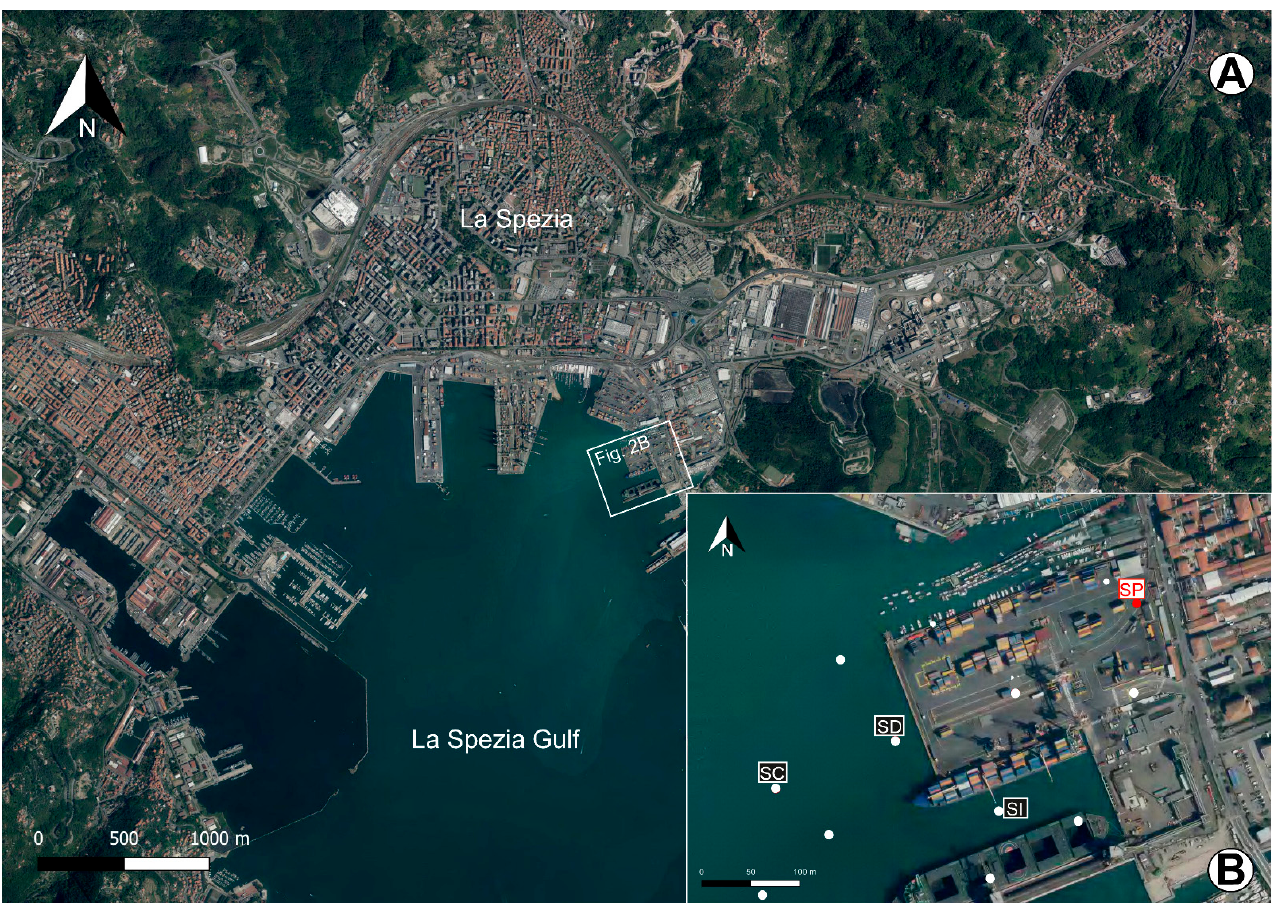
Figure 2. Close-up view of the harbour area of GLS ( A ) and its eastern terminal, where the coring campaign (cores are reported as white dots) was undertaken ( B ). The studied core SP is highlighted in red; other cores discussed in the text are highlighted in white. Basemap (aerial photos) from the “Geoportale della Regione Liguria” [26].